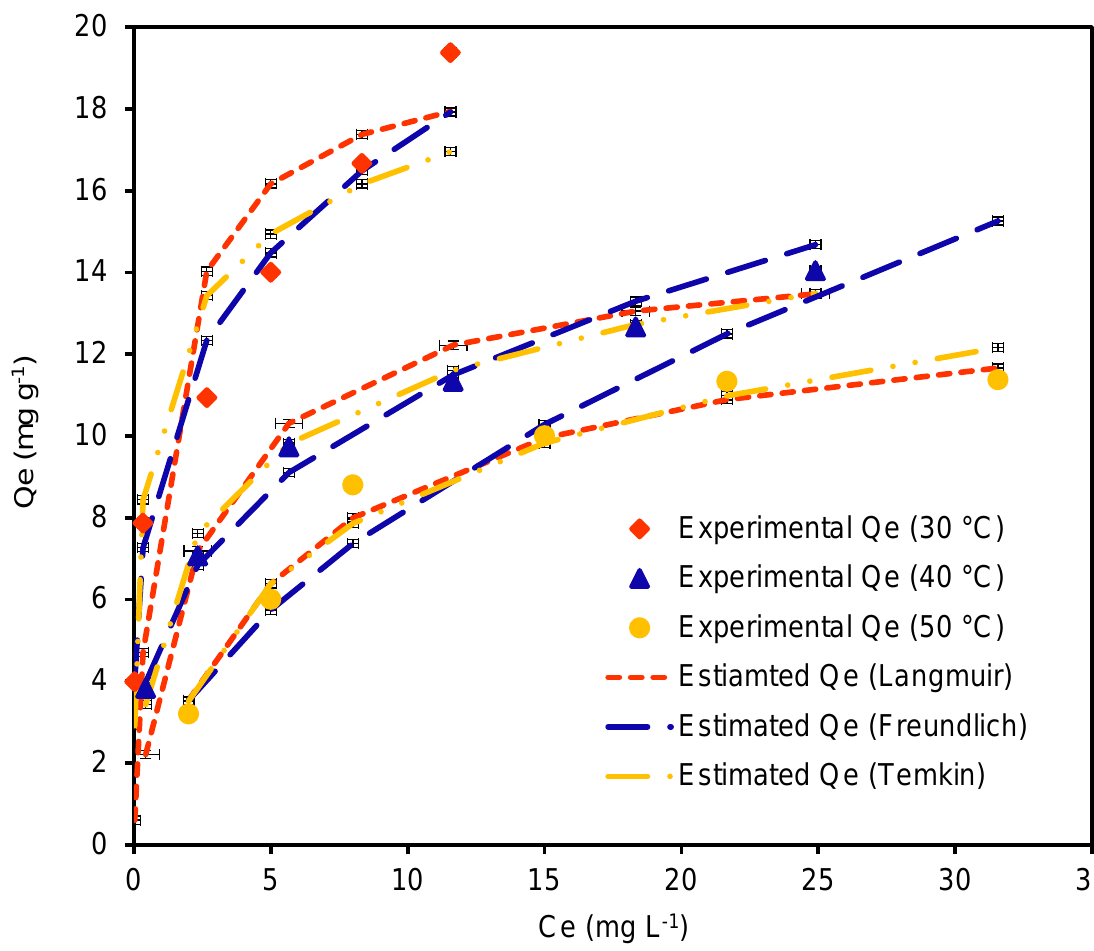
Figure 6. Plot of isotherms simulation, (Experimental conditions: Adsorbent dose = 2.5 g L −1 ; Contact time = 135 min; Agitation speed = 200 rpm; Solution pH = 7). Table 4. Isotherm studies for CR adsorption onto Cu-ZnBO-Cp-CT **. Temp., Order ◦